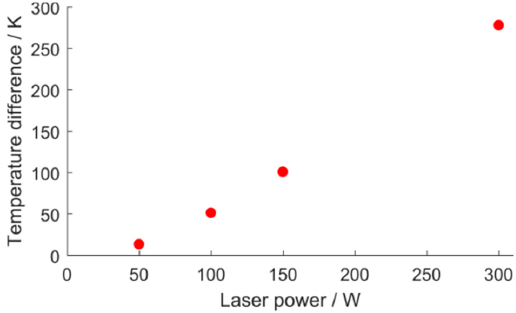
Figure 3. Temperature differences inside the SiC specimen at 1 s irradiation time as function of laser power.